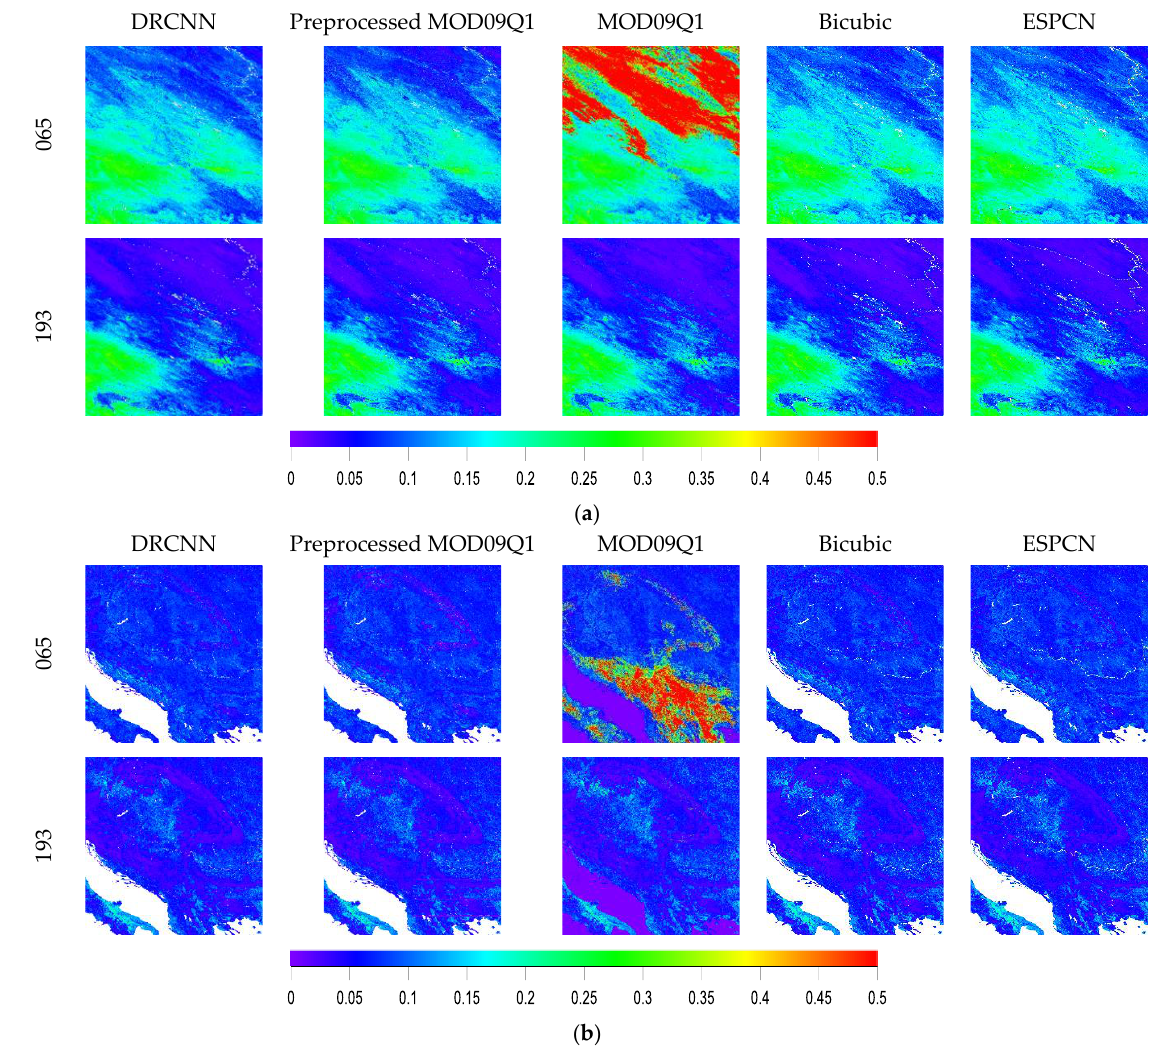
Figure 6. Comparisons of the downscaled surface reflectance from the DRCNN with the surface reflectance in the red band from the MOD09Q1 product, the surface reflectance in the red band from the preprocessed MOD09Q1 product, and the surface reflectance in the red band downscaled by the bicubic interpolation method and the ESPCN method on days 65 and 193 in 2015 at ( a ) h26v04 and ( b ) h19v04.